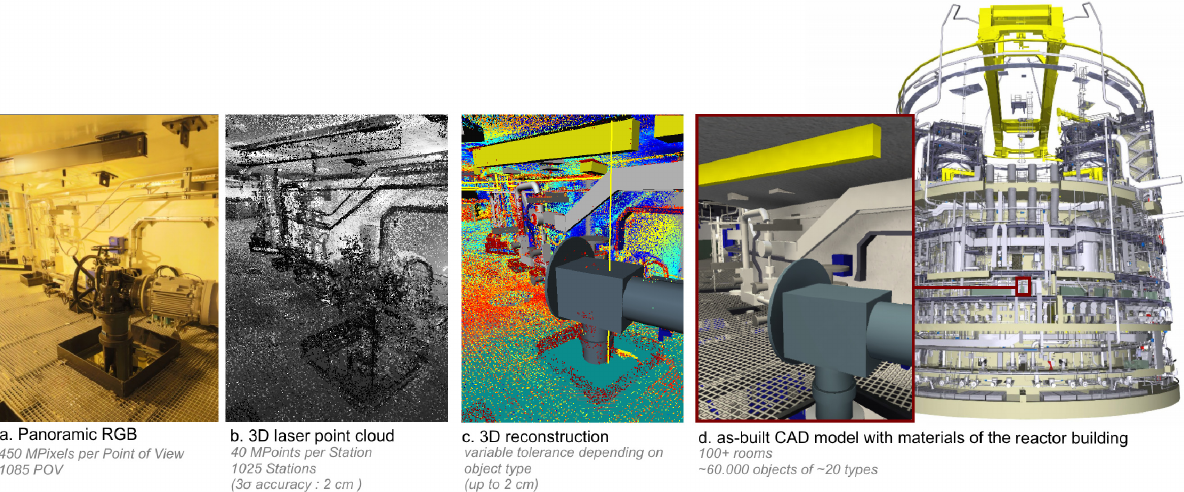
Figure 4: Dense data sources used for as-built reconstruction of the nuclear reactor building from point clouds. Each type of 3D object is reconstructed with specific rules (fitting tolerances and naming